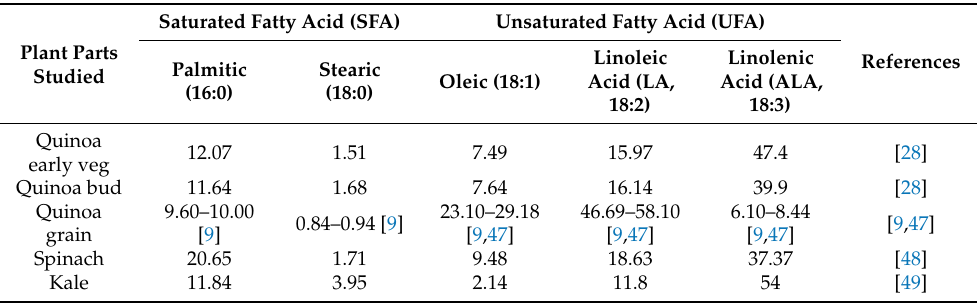
Table 3. Fatty acid profile of quinoa plant parts at different growth stages, spinach, and kale. Numbers in parenthesis refer to citations from which the fatty acid profile data were